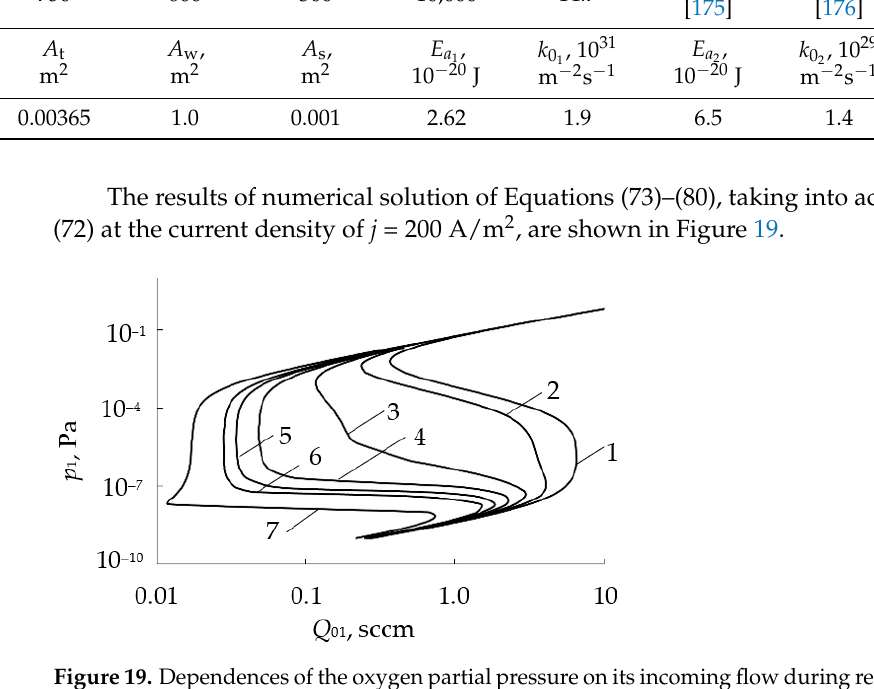
Figure 19. Dependences of the oxygen partial pressure on its incoming flow during reactive sputtering of a titanium target in Ar+O 2 +N 2 with the current density 200 A/m 2 and an incoming nitrogen